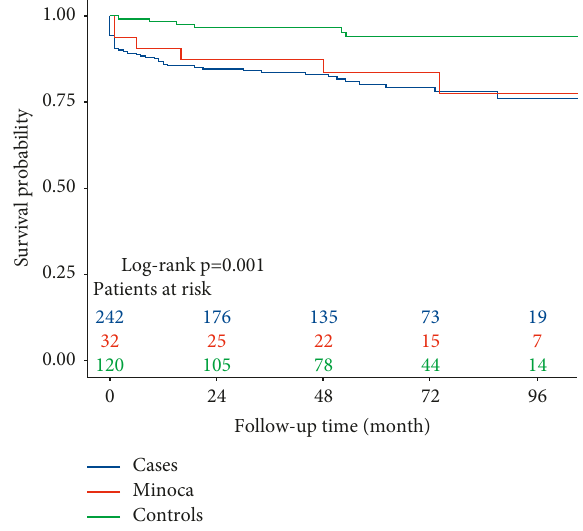
Figure 1: Clinical outcomes of obstructive CAD (cases), MINOCA and control groups at the time of the first